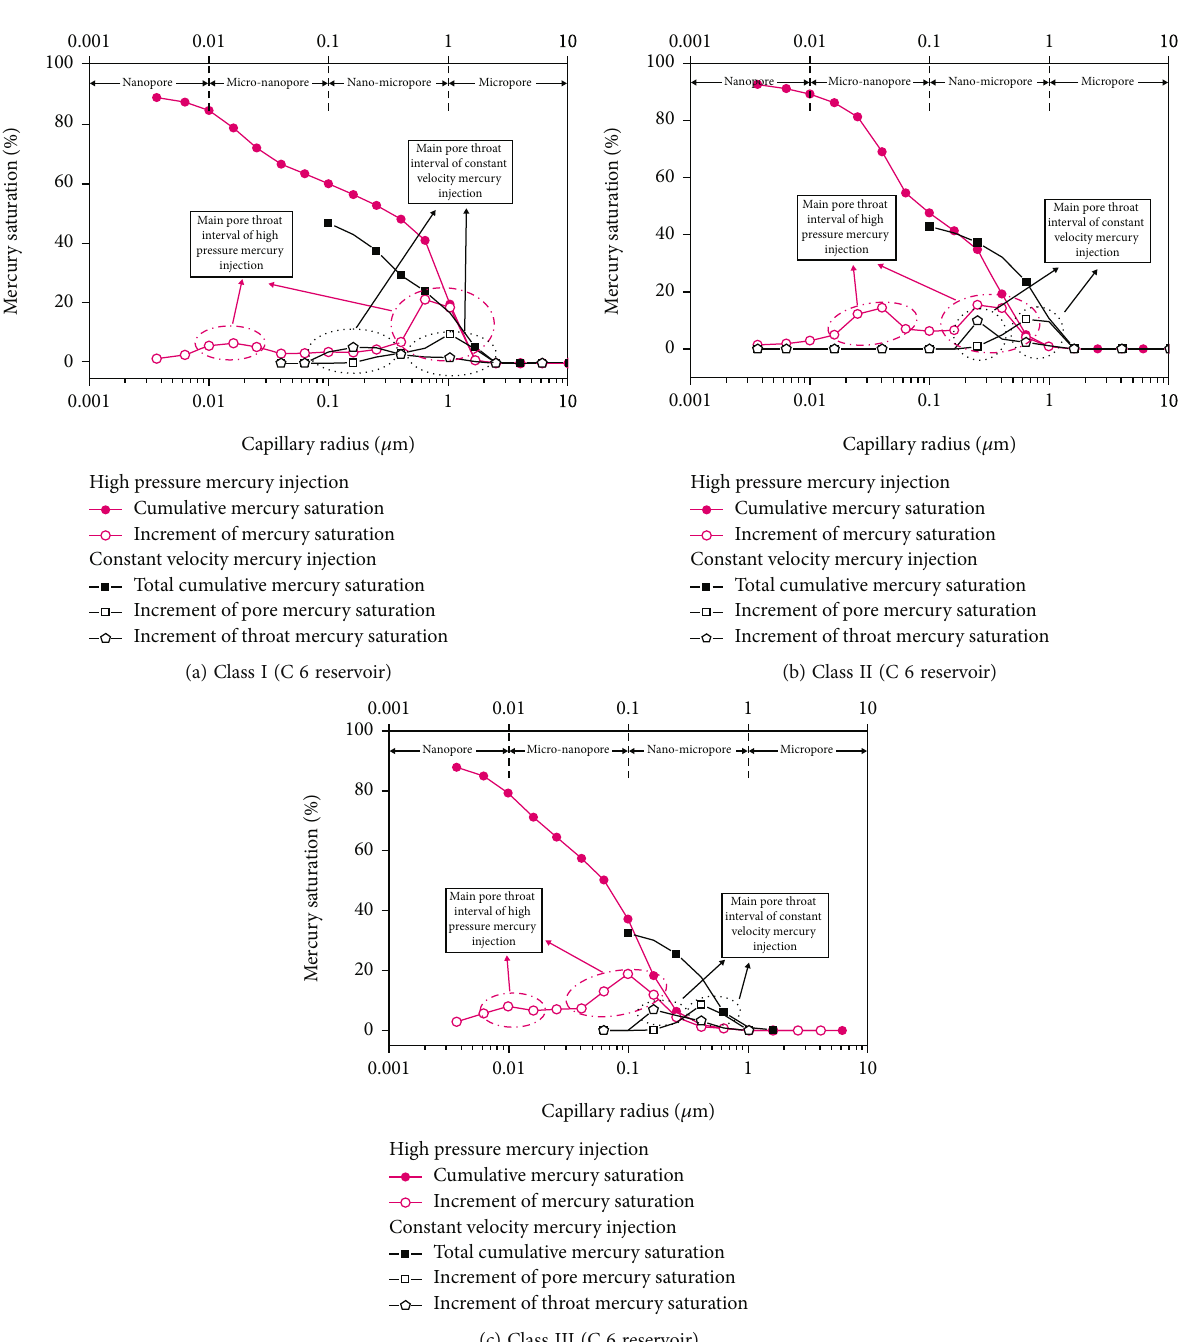
Figure 9: Superposition diagram of pore throat distribution and cumulative mercury saturation curve of C 6